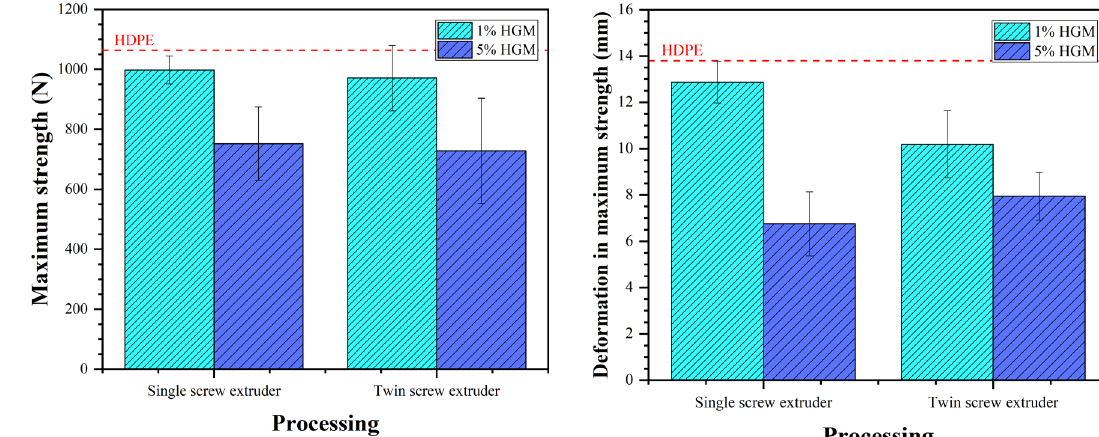
Figure 7. Deformation in maximum strength x